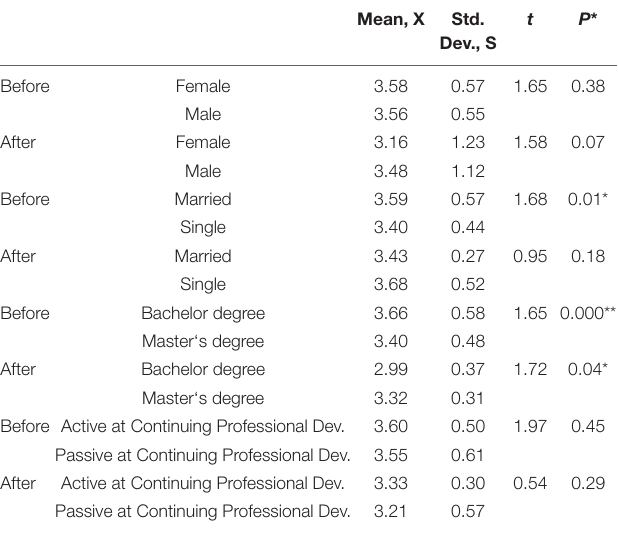
Mean, X Std. Dev., S F P *